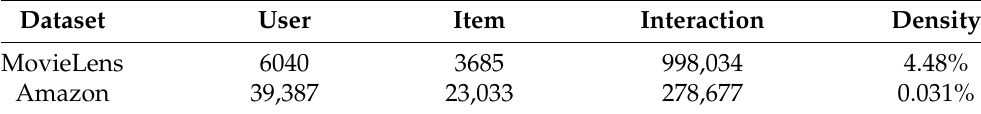
Table 1. Introduction of the MovieLens dataset and the Amazon dataset.